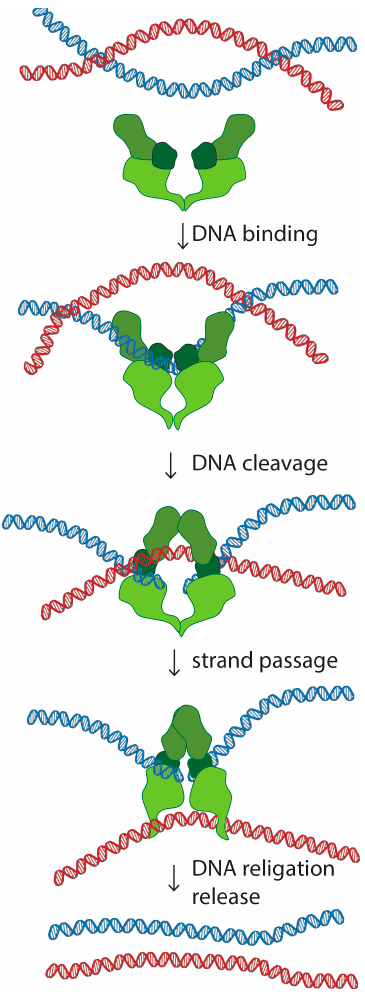
Figure 1. Mechanism of DNA decatenation by topoisomerase II. Topoisomerase II binds to one of the entangled (catenated) DNA molecules. The reaction involves cleavage of the bound DNA strand (blue), introducing a double strand break. Topoisomerase II remains covalently connected to the cut DNA, preventing its dissociation. Once the continuity of one of the DNA strands is severed, topoisomerase II can transport the other DNA molecule (marked in red) through the created gap. Upon strand passage, the cleaved DNA is ligated back together, and topoisomerase II releases the DNA molecule.